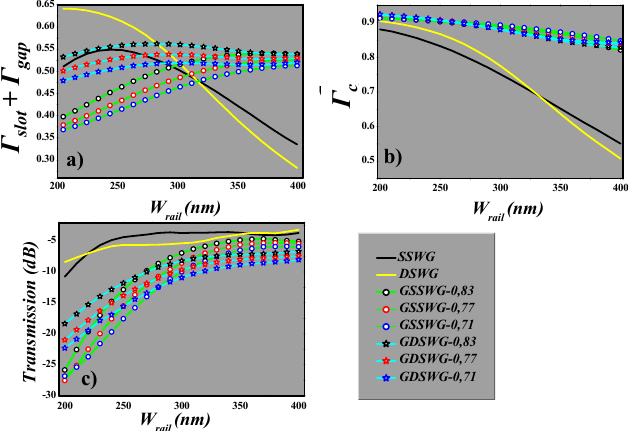
Figure 5. Variation of ( a ) Γ slot + Γ gap , ( b ) Γ c , ( c ) Transmission (dB), on the WG width ( W rail